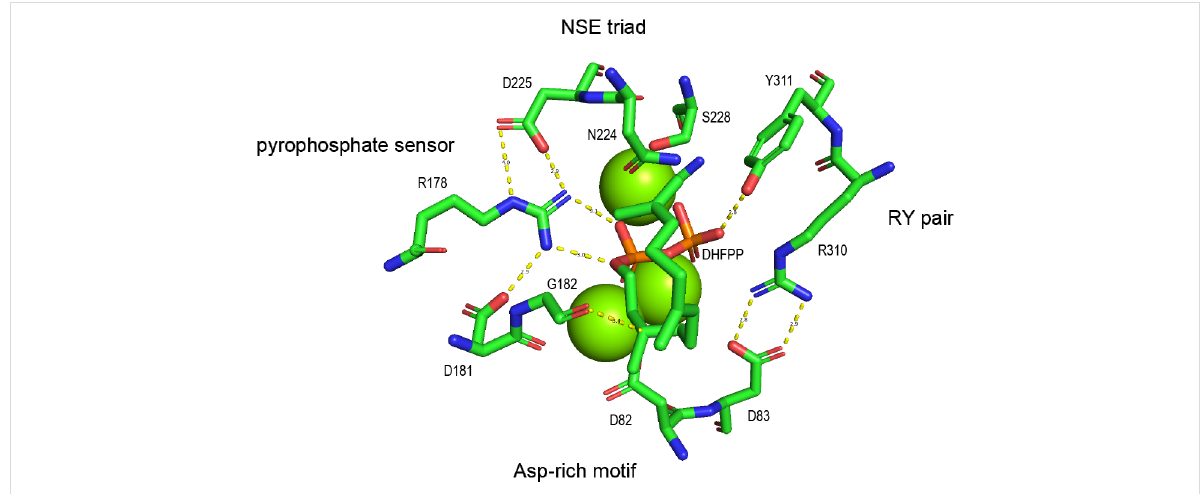
Figure 1: Highly conserved residues in the active site of SdS for Mg 2+ complexation, substrate recognition and activation. DHFPP = 2,3-dihydro-FPP.